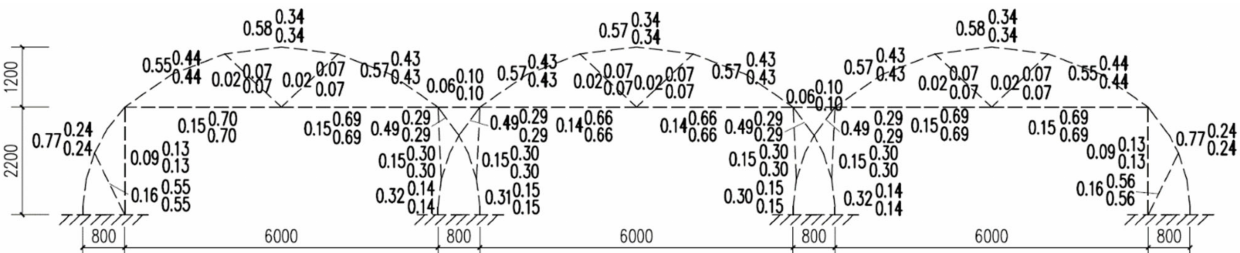
Figure 8. Stress ratios of structural calculation (unit: mm). Notes: The number on the left of each component is the strength stress ratio, that on the upper right is the in-plane stability stress ratio, and that on the lower right is the out-of-plane stability stress